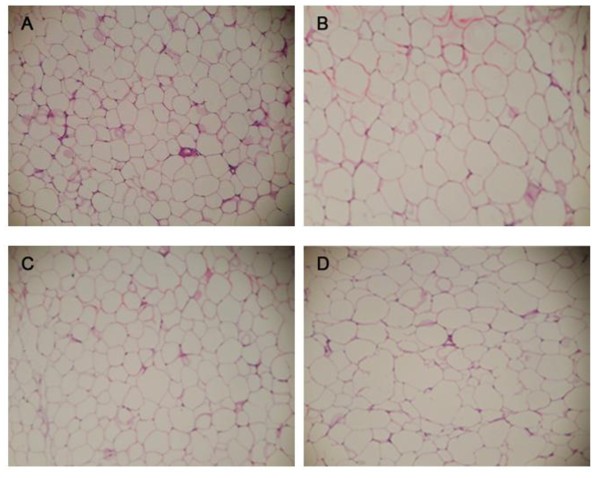
Adipocytes in WAT sections in the four groups. A: normal diet; B:high-cholesterol diet; C: high-cholesterol diet + L. plantarum 9-41-A; D: high-cholesterol diet + L. fermentum M1-16. All the photomicrographs show HE staining (original magnification × 400).